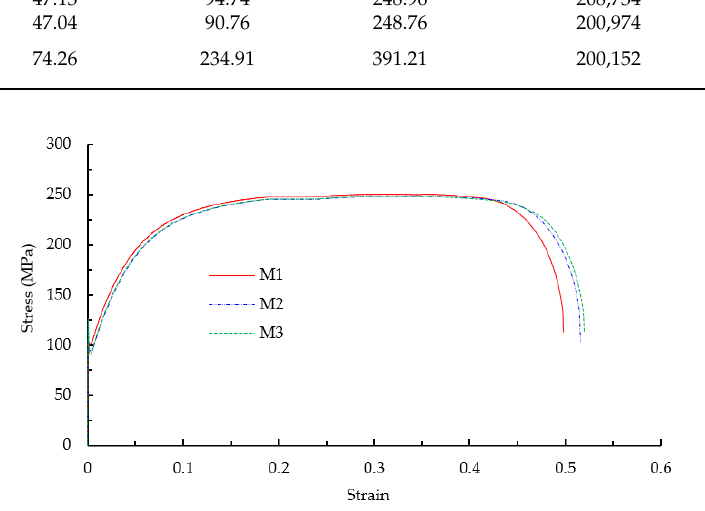
Figure 8. Stress-strain curves of the LYP steel.